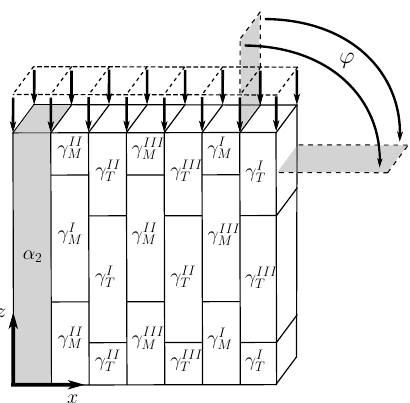
Figure 5. Representative volume element of polysynthetically twinned crystal. ϕ : angle between uniaxial load and lamella plane; γ I − III : six orientation variants of γ phase (three matrix and three M / T twin orientations).